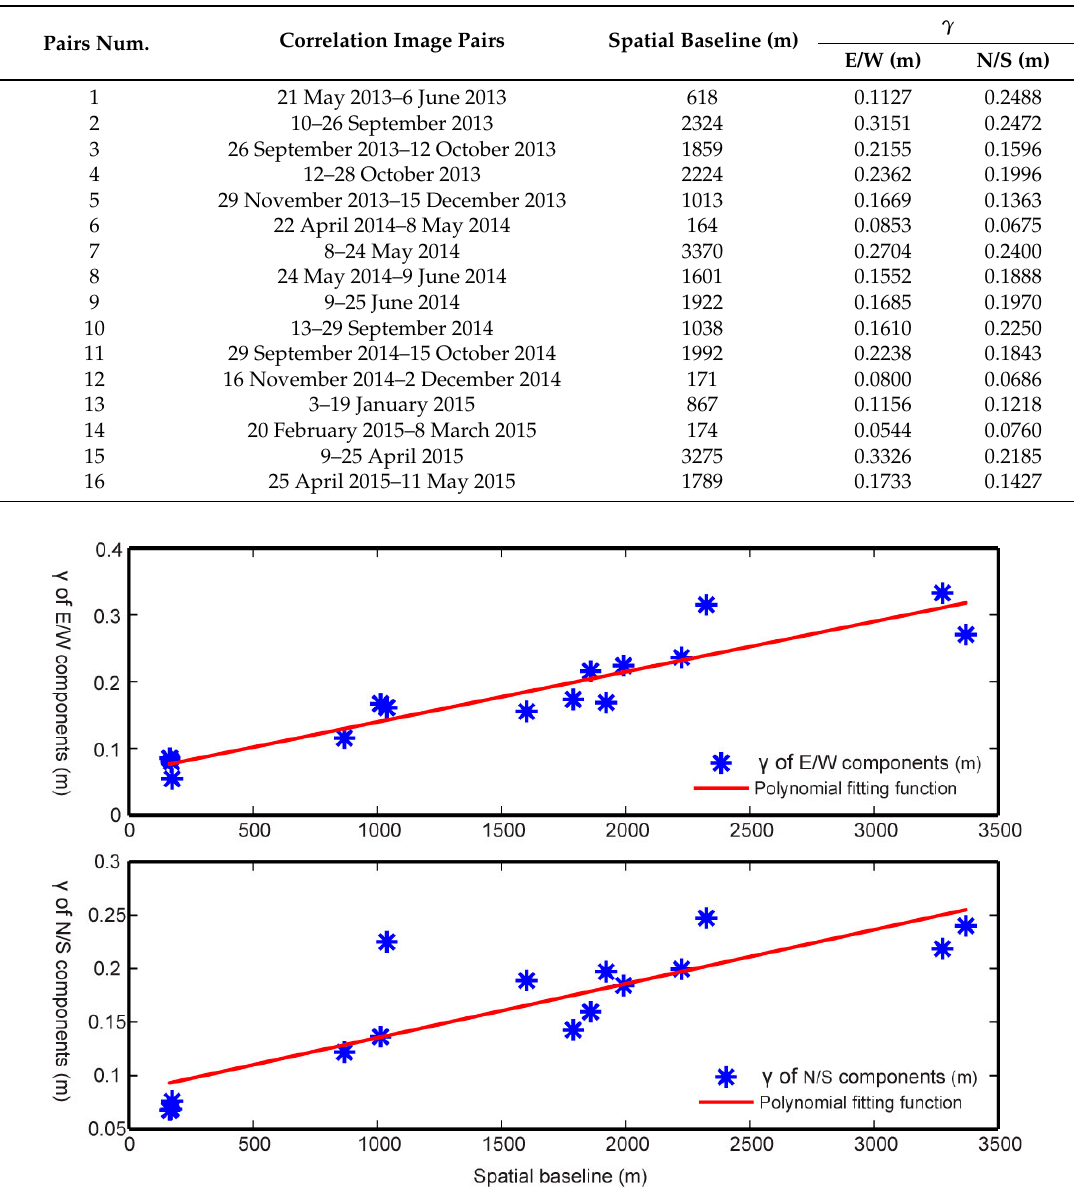
Figure 6. Correlation analysis of γ and spatial baselines of the correlated image pairs. Note that we deleted the first dataset due to high measurement bias, and fit the function using the other 15 datasets.